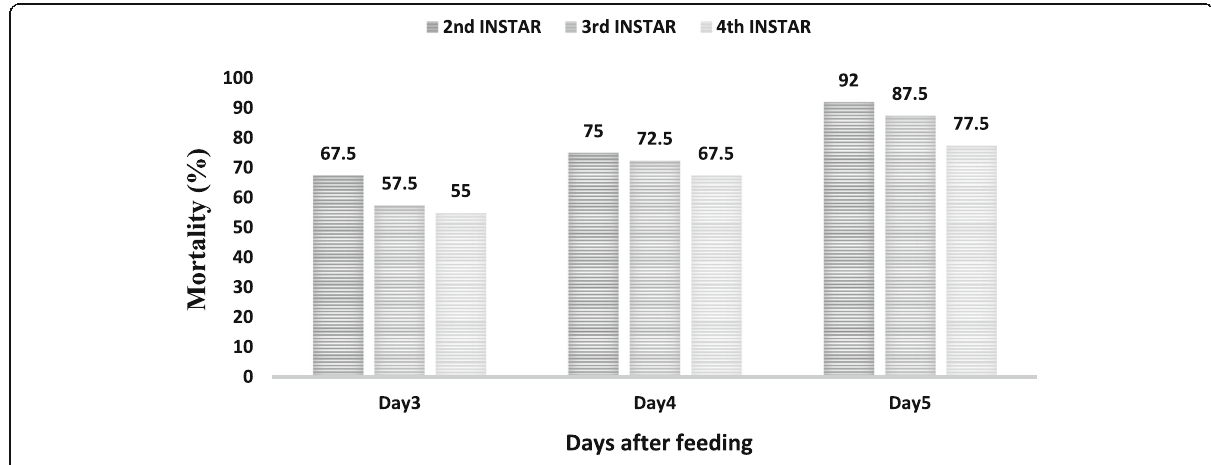
Fig. 1 Mortality of different larval instars of Tuta absoluta caused by 4D1 at LC 50